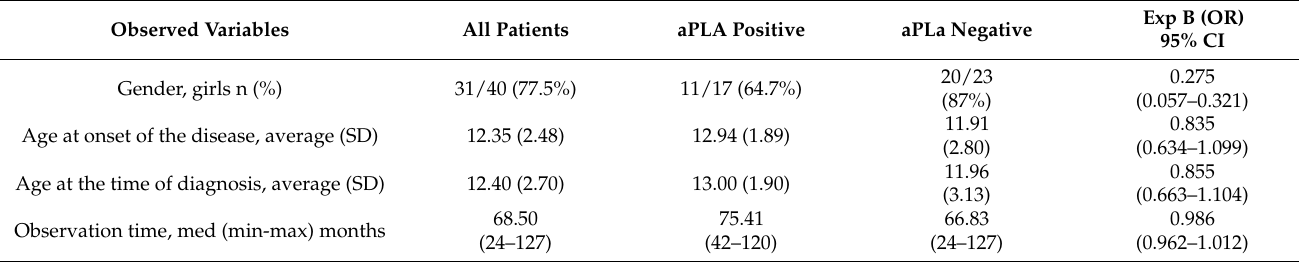
Table 1. Demographic characteristics of the respondents.